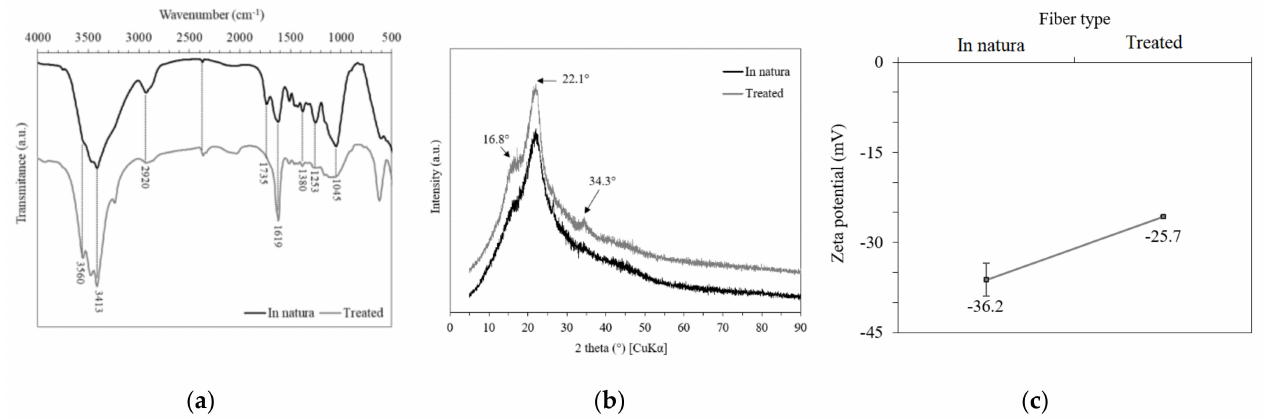
Figure 2. Characterization of the aça í fibers. ( a ) FTIR spectra; ( b ) XRD patterns; ( c ) Zeta potential (average ± standard deviation of three